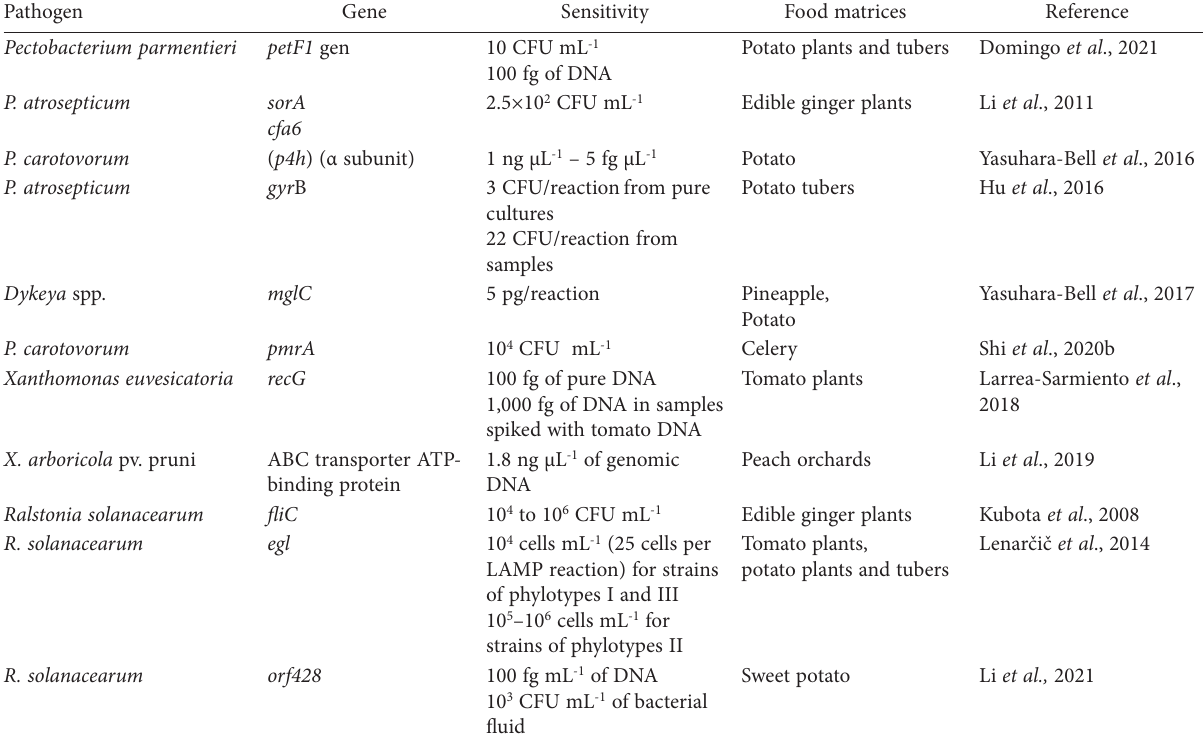
Table 3. LAMP assays for postharvest bacterial pathogens. Pathogen Gene